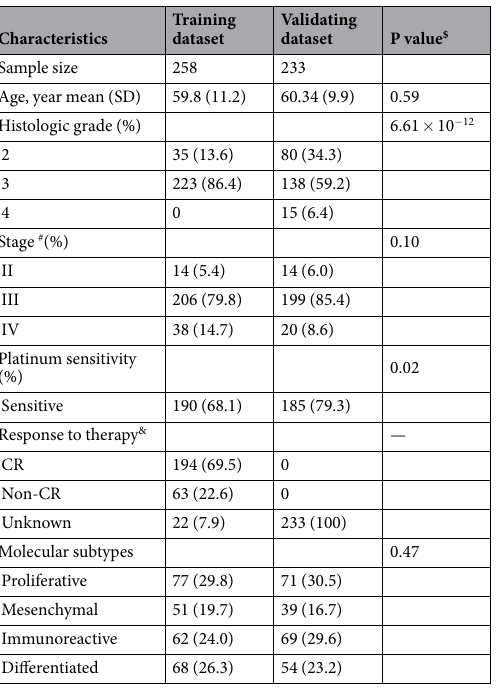
Table 4. Patient characteristics of the training and validating datasets. # Stage based on the International Federation of Gynecology & Obstetrics (FIGO). & CR means the complete response, and Non-CR depicts a non-complete response, including partial response, progressive disease, and stable disease. $ p values for the difference between the derivation and validation cohorts were calculated using independent sample t-test (for age and height) and Chi square test (for histologic grade, stage, platinum sensitivity, response to therapy, and molecular